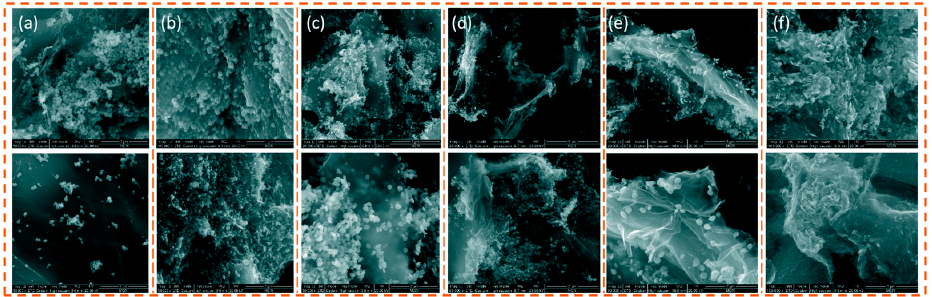
Figure 4-6. SEM and TEM images of Fe 2 O 3 /rGO composites fabricated in different solvents: ( a ) NBA, ( b ) H 2 O, ( c ) EA, ( d ) NMP, ( e ) DMF, and ( f ) EG. ( a – f ) Reproduced with the permission of ref. [101]. Copyright 2018, Crystengcomm.